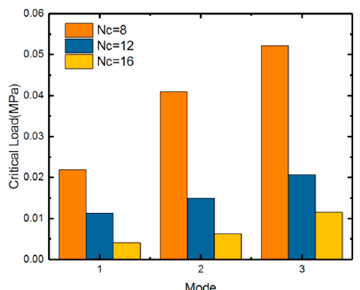
Figure 4. First three orders buckling eigenvalues of SMP stent with different numbers in circumferential direction: Nc = 8/12/16.